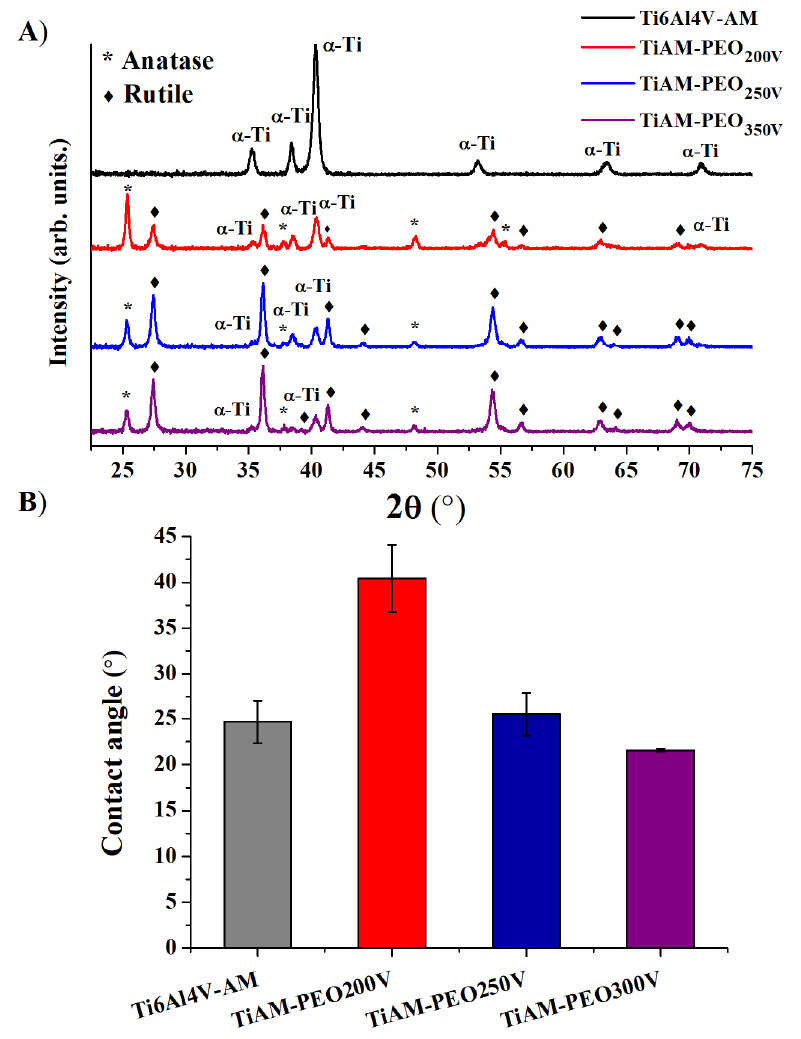
Figure 3. ( A ) Grazing incidence X-ray patterns of PEO coatings and ( B ) Contact angle values obtained for PEO coatings on Ti-6Al-4V ELI alloy processed by L-PBF. The GIXRD analysis indicates the formation of coatings composed of two different phases of TiO 2 oxide: anatase (JCPDS NO. 01-084-1286)—TiO 2 and rutile (JCPDS NO.01- 077-0442)—TiO 2 phases; only Ti α -phase peaks were detected on Ti-6Al-4V ELI alloy pro-